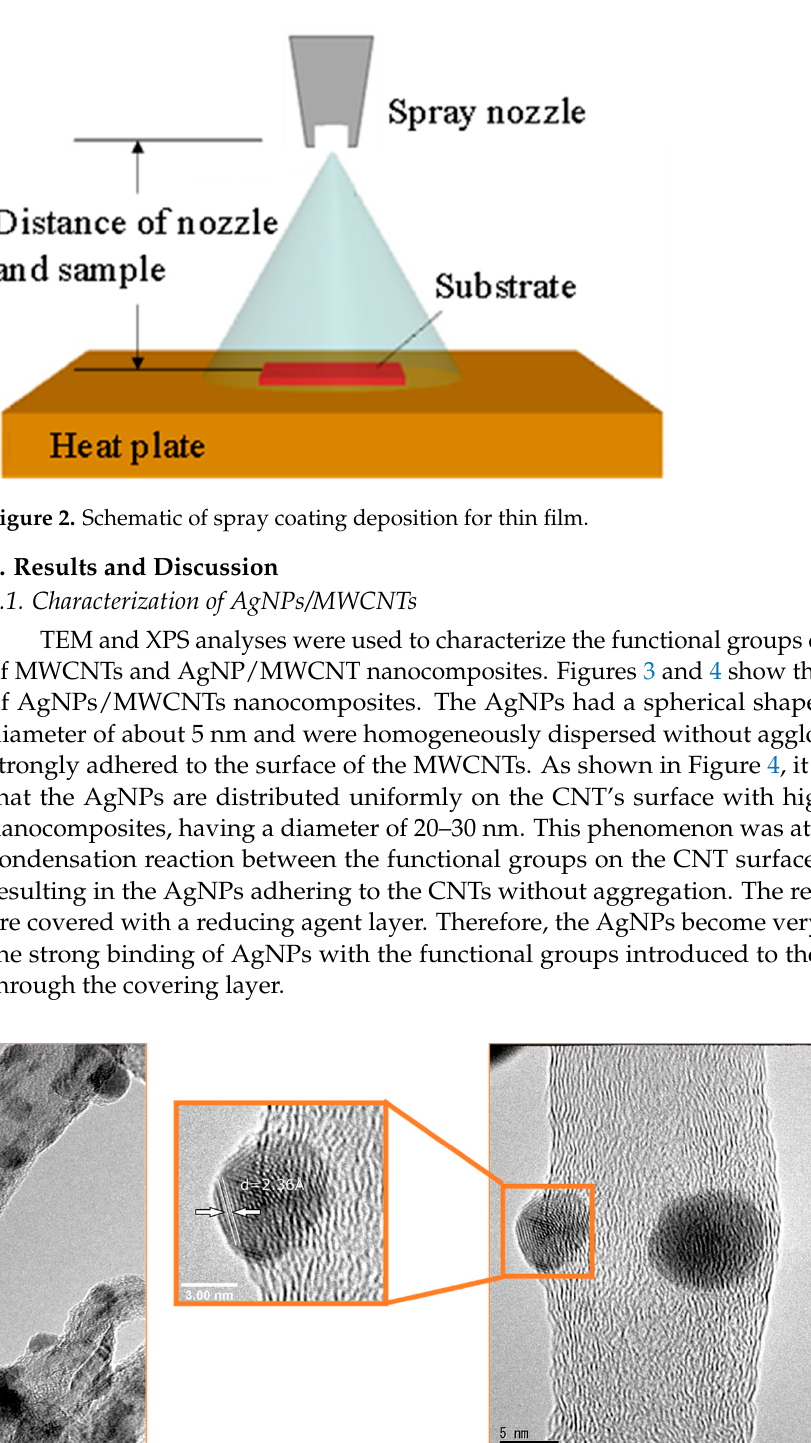
Figure 4. TEM micrograph of the distribution image of AgNPs attached on the CNTs.